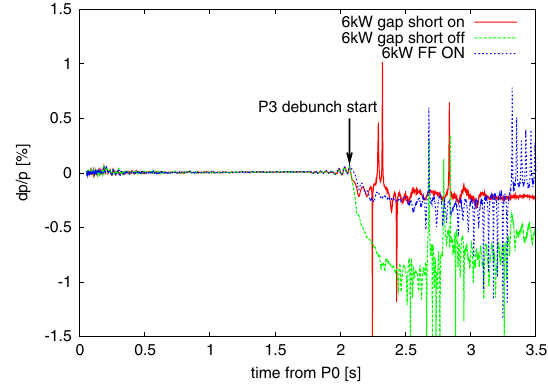
FIG. 16. Comparison of the momentum deviation during the debunching process, without feedforward and gap short, with feedforward, and with gap